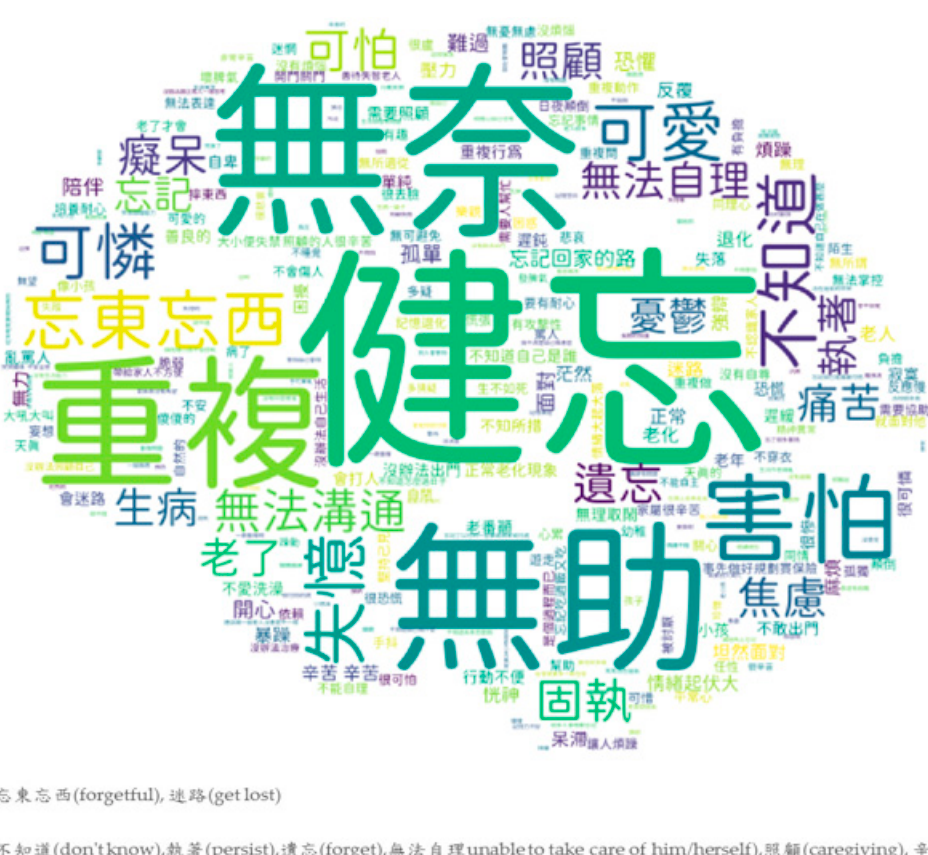
Figure 1. Word clouds of feelings toward dementia. Note: Translation of frequent Chinese characters: 健忘 / 忘東忘西 / 忘記 / 失憶 / 遺忘 (forgetful, forget, loss of memory), 害怕 (afraid)/ 恐懼 (fear), 無助 / 無奈 (helpless), 可憐 (pitiful), 照顧 (caregiving), 可怕 (terrifying), 憂鬱 (depression), 焦慮 (anxiety), 重複 (repeatedly), 迷路 / 忘記回家的路 (get lost), 辛苦 (hard), 無法溝通 (incommunicable), 固執 (stubborn), 退化 (regenerate), 麻煩 (trouble), 痛苦 (suffering), 不知道 (don’t know), 正常老化 / 老了 (normal aging), 可愛 (cute), 開心 (happy), 無法自理 (unable to take care of him/herself), 孤單 (lonely).